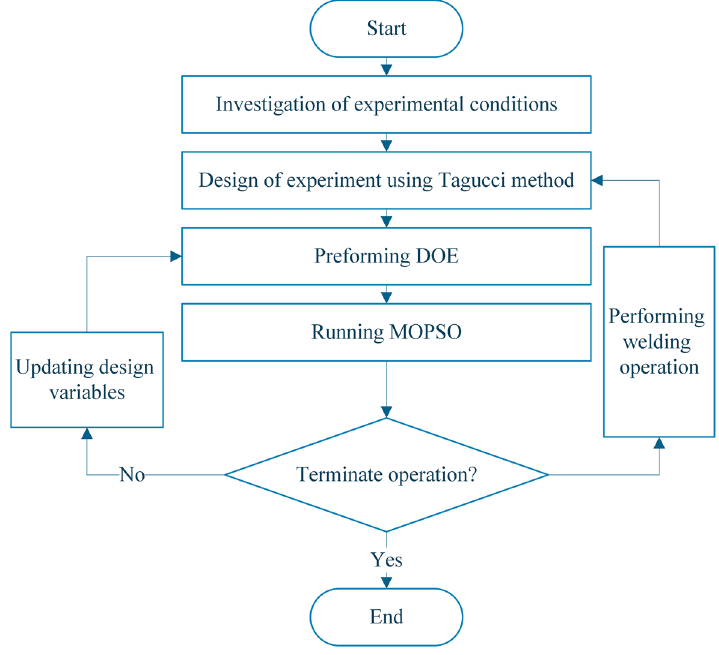
Figure 2. Multi-objective optimization